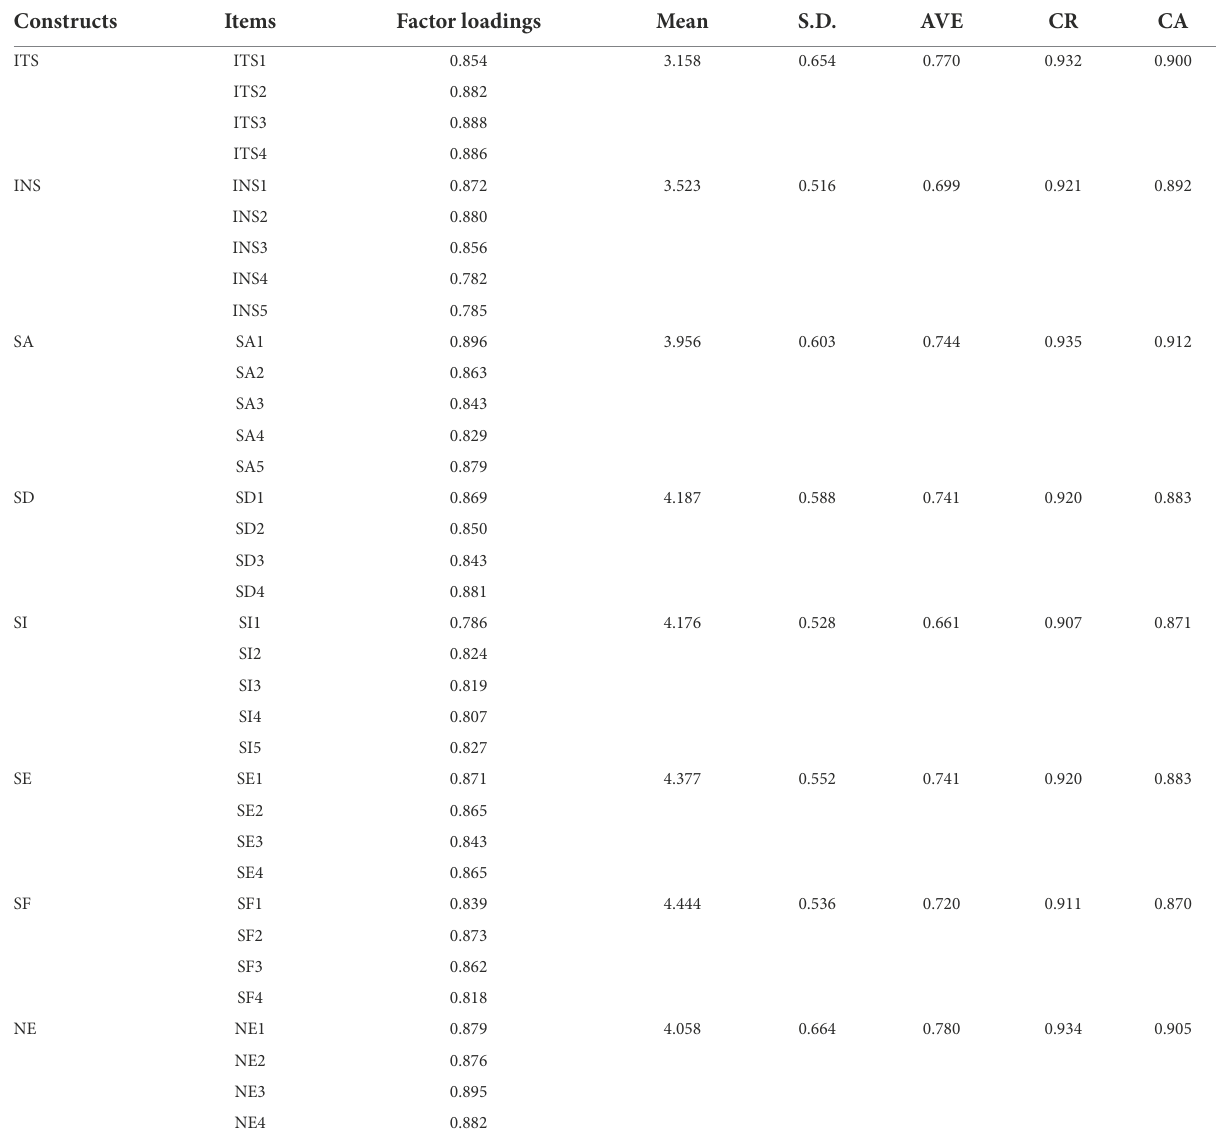
TABLE 3 Indicator reliability and convergent validity statistics.